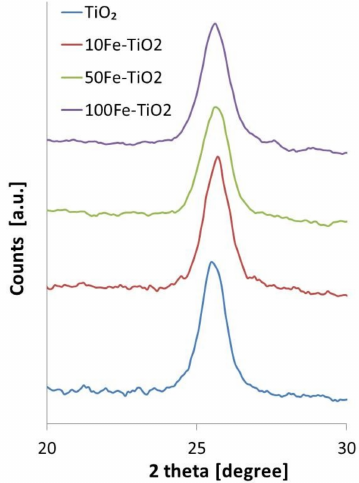
Figure 3. XRD spectra of the photocatalysts in the range 20 ◦ –30 ◦